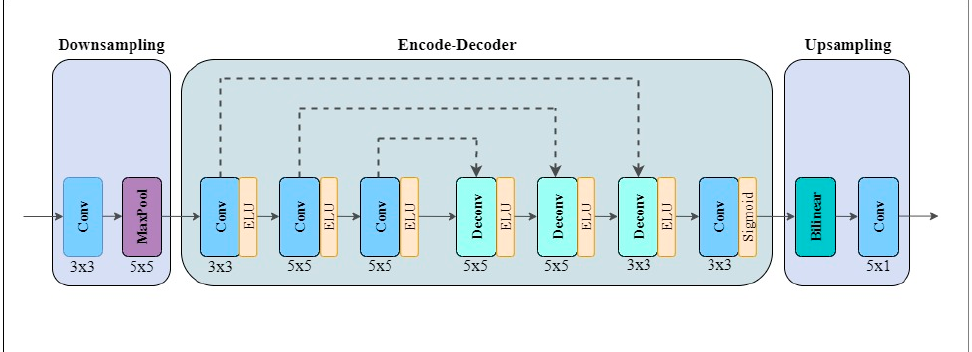
Figure 4. TGL-Net’s Symmetric architecture, comprised of three stages: downsampling, encoder– decoder, and upsampling. Dotted lines are skip connections [65].